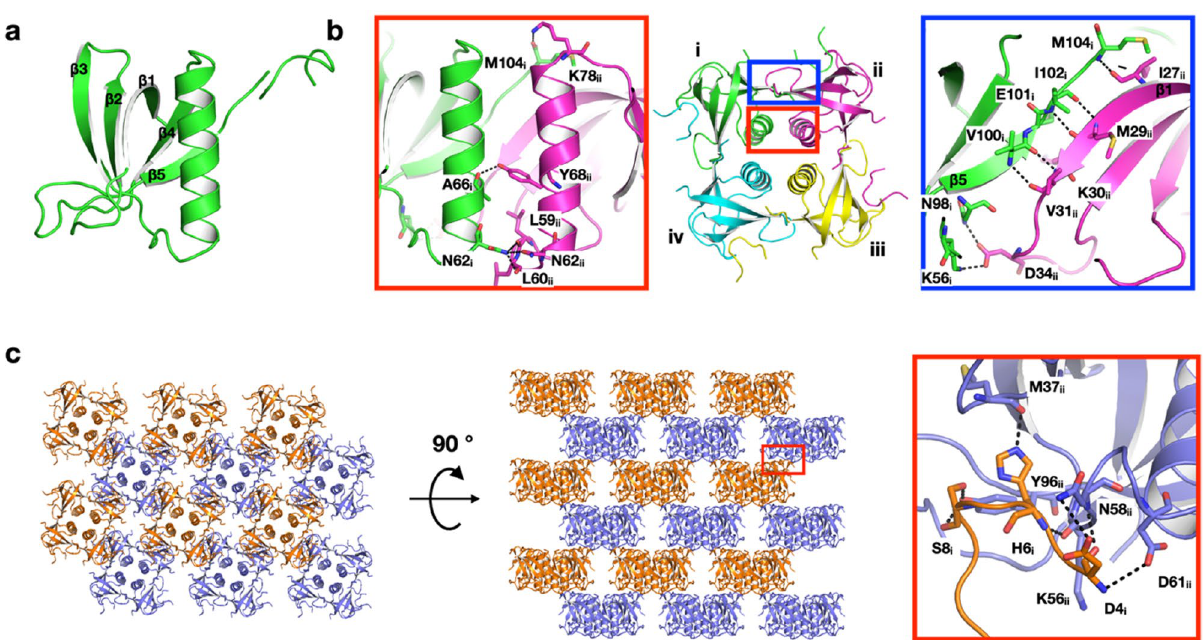
Figure 5. Crystal structure of CipAC-CF with 1,4-dioxane. The structure of ( a ) monomer and ( b ) tetramer. ( a ) CipA monomer are consists of the N-terminal arm followed by three β-strands β1, β2, β3, α-helix, and β-strands β4 and β5. ( b ) the interactions between monomers (i, ii, iii and iv) in the tetramer. ( c ) Lattice structure and interactions between tetramers. Hydrogen bonds are indicated with black dotted